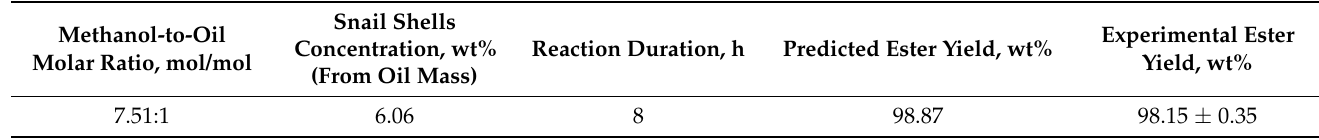
Table 4. Optimum parameters for rapeseed oil methyl ester production, and predicted and experi- mental ester yield.